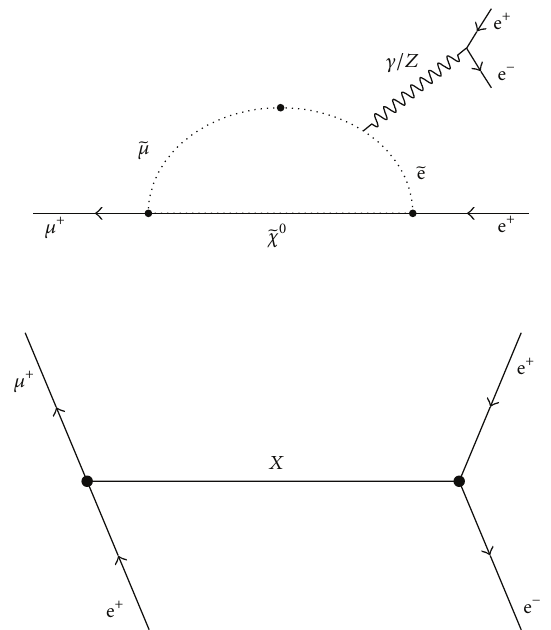
Figure 17: Feynman diagrams which induce the 𝜇 + → e + e − e +